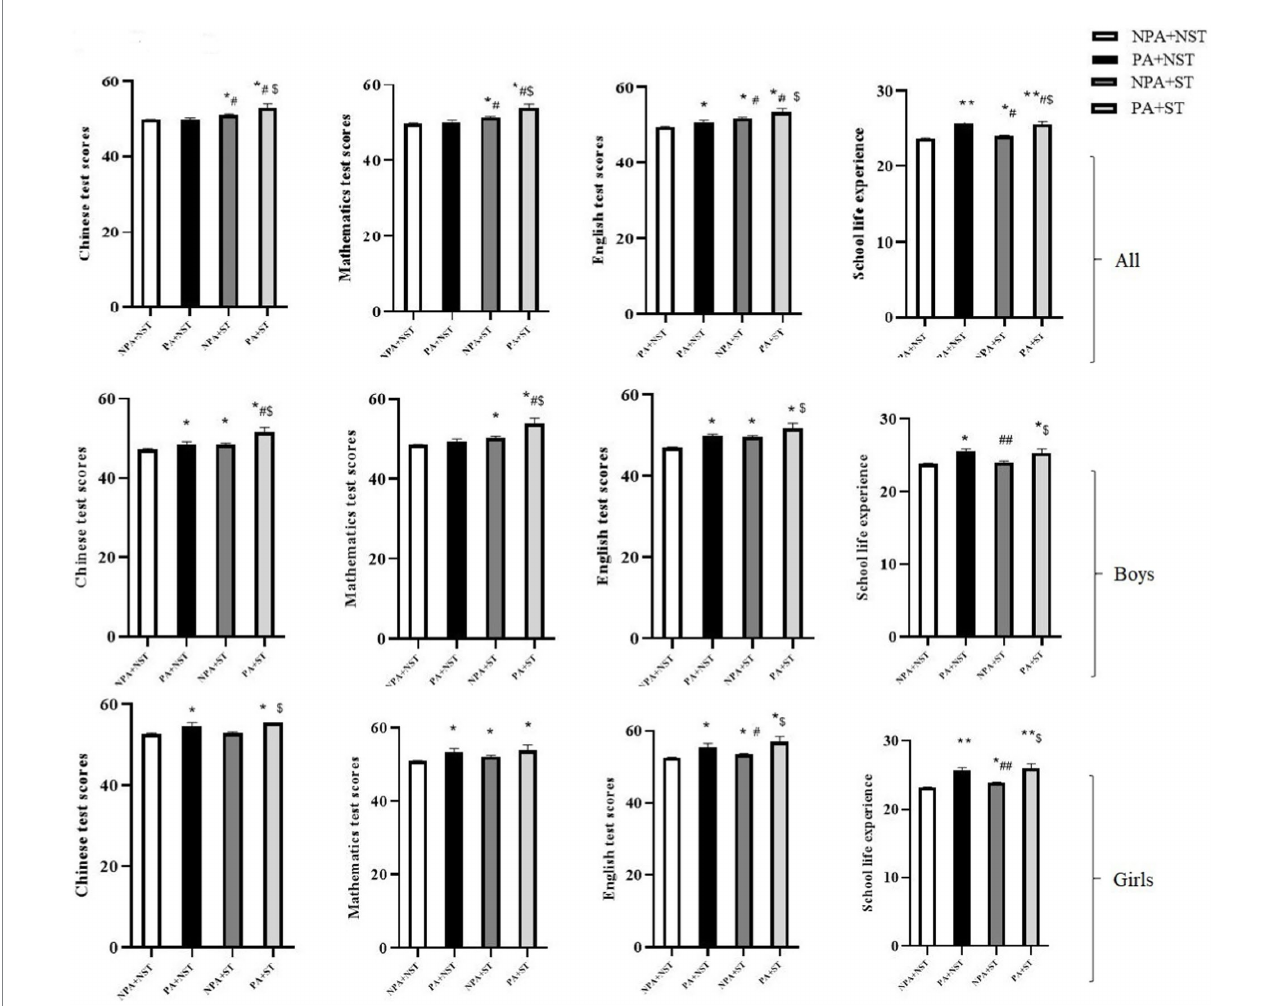
FIGURE 1 Academic performance of adolescents in different categories.* represents comparison with the NPA + NST group, p < 0.05; ** represents comparison with the NPA + NST group, p < 0.01; # represents comparison with the PA + NST group, p < 0.05; ## represents comparison with the PA + NST group, p < 0.01. $ represents comparison with NPA + ST group, p <